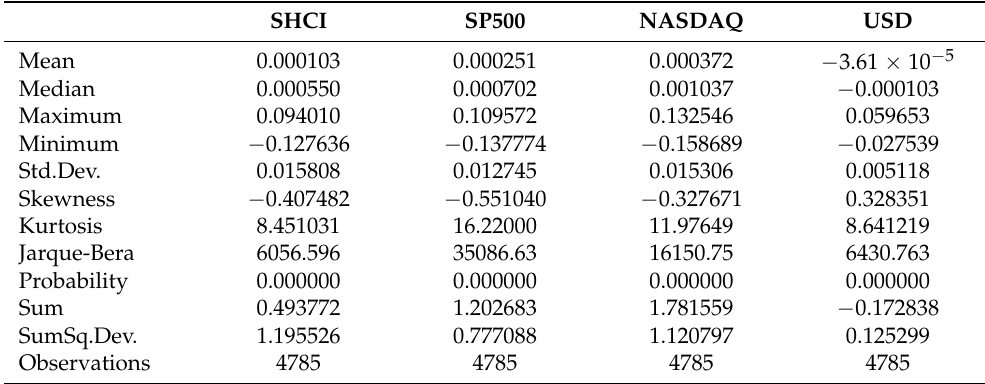
Table 1. Data descriptive and statistics.